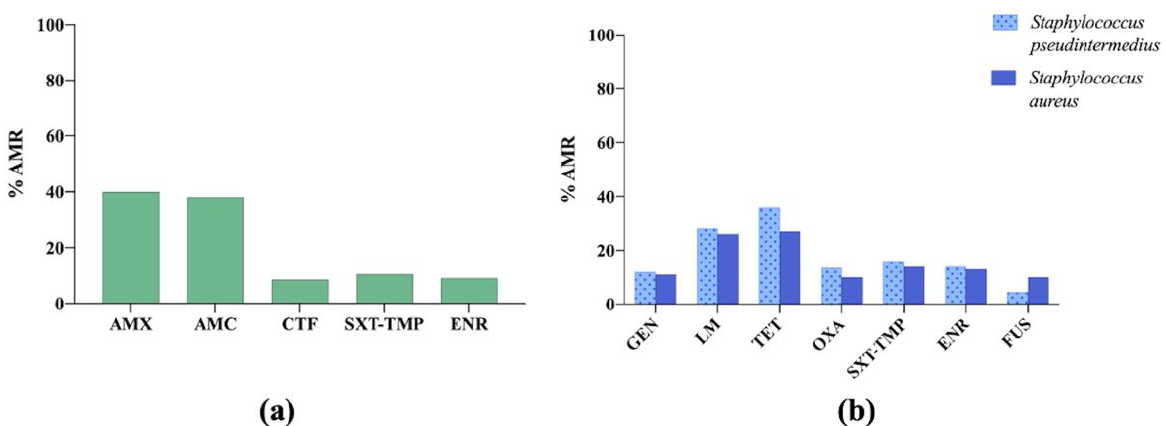
Figure 5. ( a ) Antimicrobial resistance (AMR) prevalence in Escherichia coli isolated from dogs and cats in France. AMX: amoxicillin; AMC: amoxicillin – clavulanic acid; CTF: ceftiofur; SXT-TMP: sul- famethoxazole – trimethoprim; ENR: enrofloxacin. ( b ) Antimicrobial resistance (AMR) prevalence in Staphylococcus pseudintermedius and Staphylococcus aureus isolated from dogs in France. GEN: gen- tamicin; LM: lincomycin; TET: tetracycline; OXA: oxacillin; SXT-TMP: sulfamethoxazole – trime- thoprim; ENR: enrofloxacin; FUS: fusidic acid.